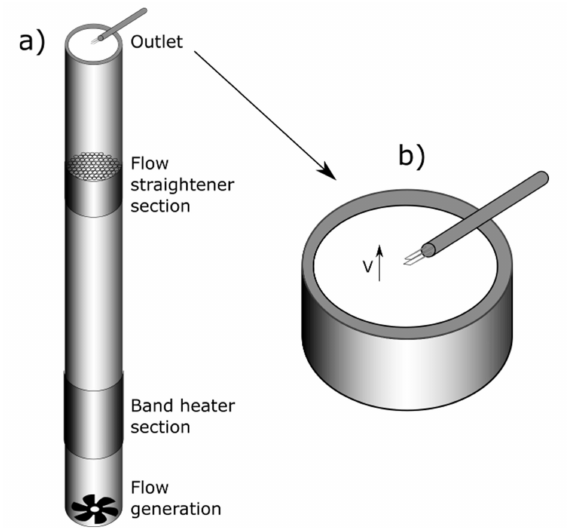
Figure 5. ( a ) Scheme of the measuring stand for setting the flow of variable temperature and velocity. ( b ) Position of the sensor during